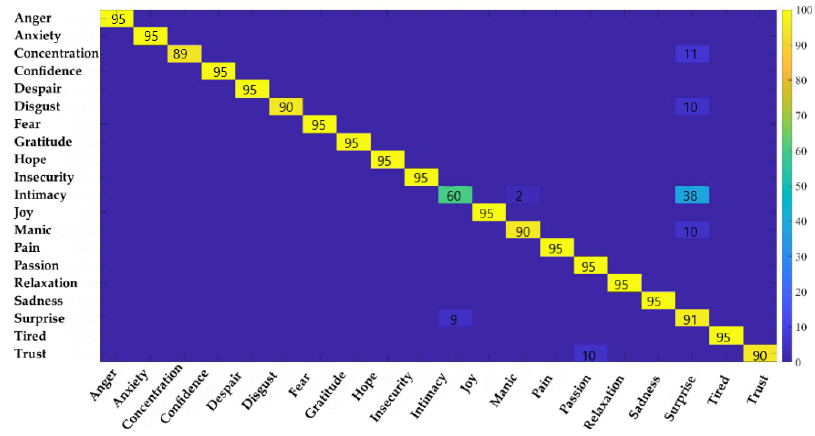
Figure 6. Confusion matrix of twenty emotions using the DEAP dataset.